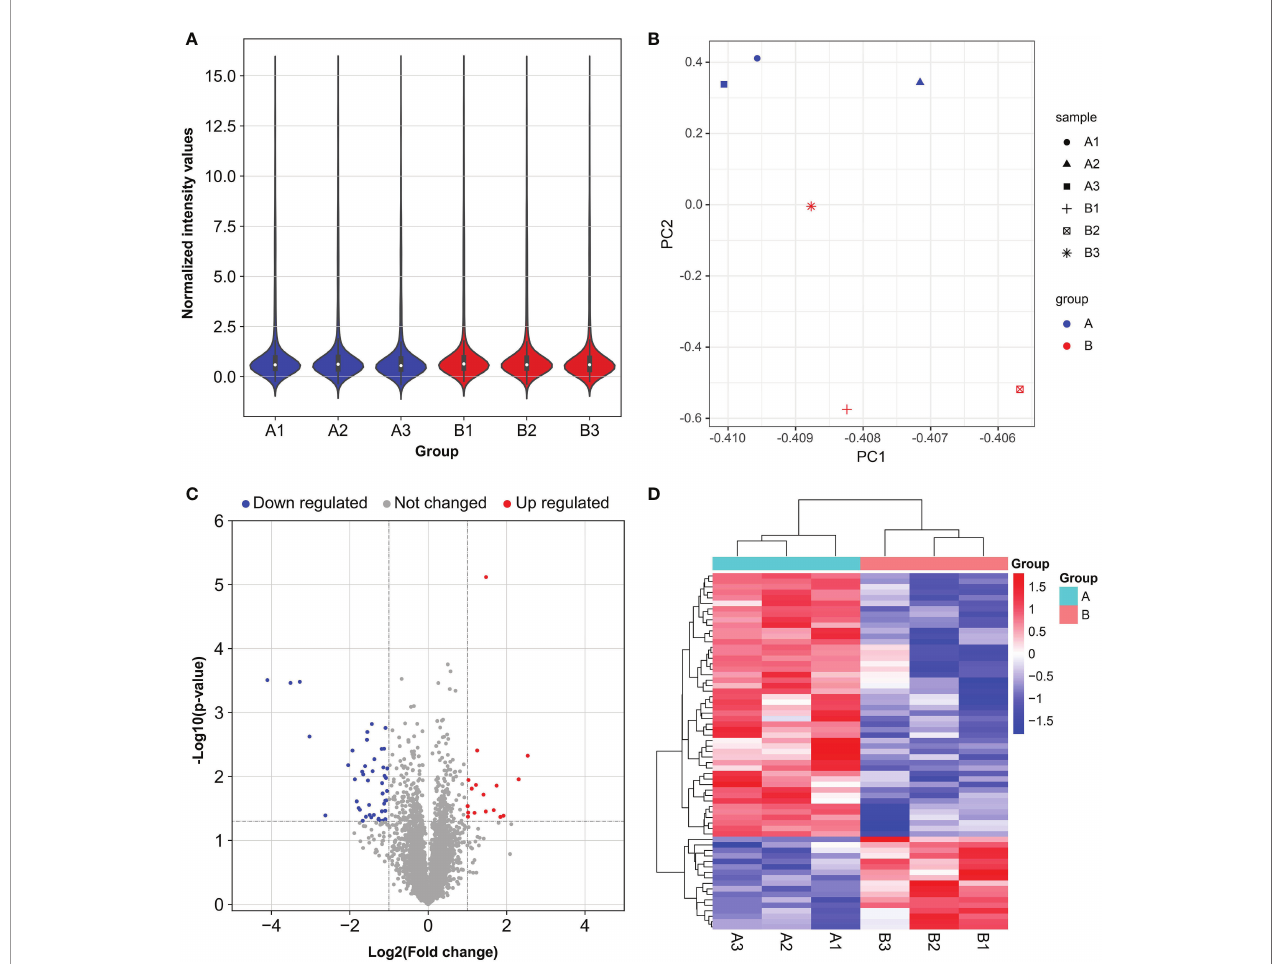
FIGURE 4 | Distinct microRNA (miRNA) expression pro fi les in A549 cells after LINC00467 knockdown. Group A (A1, A2, A3): control cells; Group B (B1, B2, B3): LINC00467 knockdown cells. (A) Violin plots showing the normalized intensity values for miRNA microarray datasets. (B) Principal component analysis of the miRNA microarray datasets. (C) Volcano plot of miRNA expression. MiRNAs with p-value < 0.05 and |fold change| ≤ 2 were determined as differentially expressed. Up regulated (red) and down regulated (blue) miRNA with twofold change are shown. (D) Heat map and hierarchical clustering of the differentially expressed miRNAs. The left vertical axis presents the clusters. The horizontal axis represents the sample groups (control cells in aqua: A1 – A3 and LINC00467 knockdown cells in red: B1 – B3). Red indicates high relative expression and blue indicates low relative